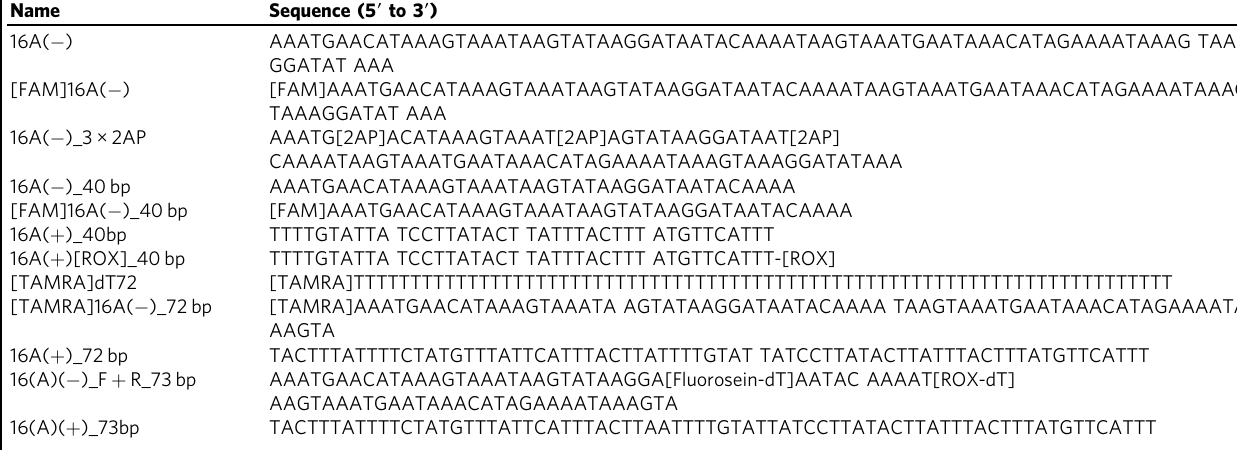
Table 1 Oligo DNA substrates used in this